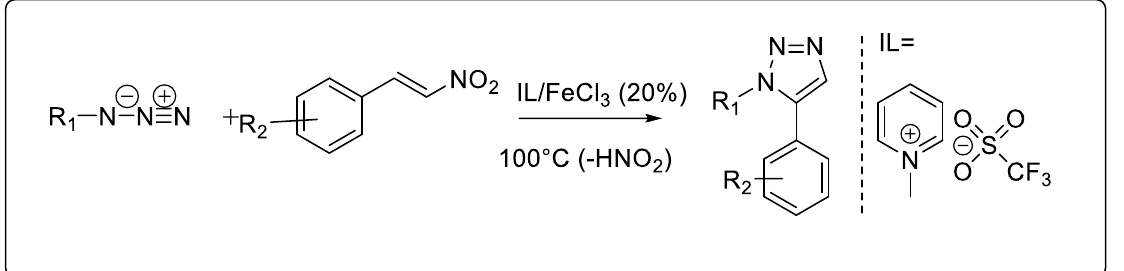
Figure 7. Choline chloride-CuCl-catalyzed Huisgen cycloaddition.